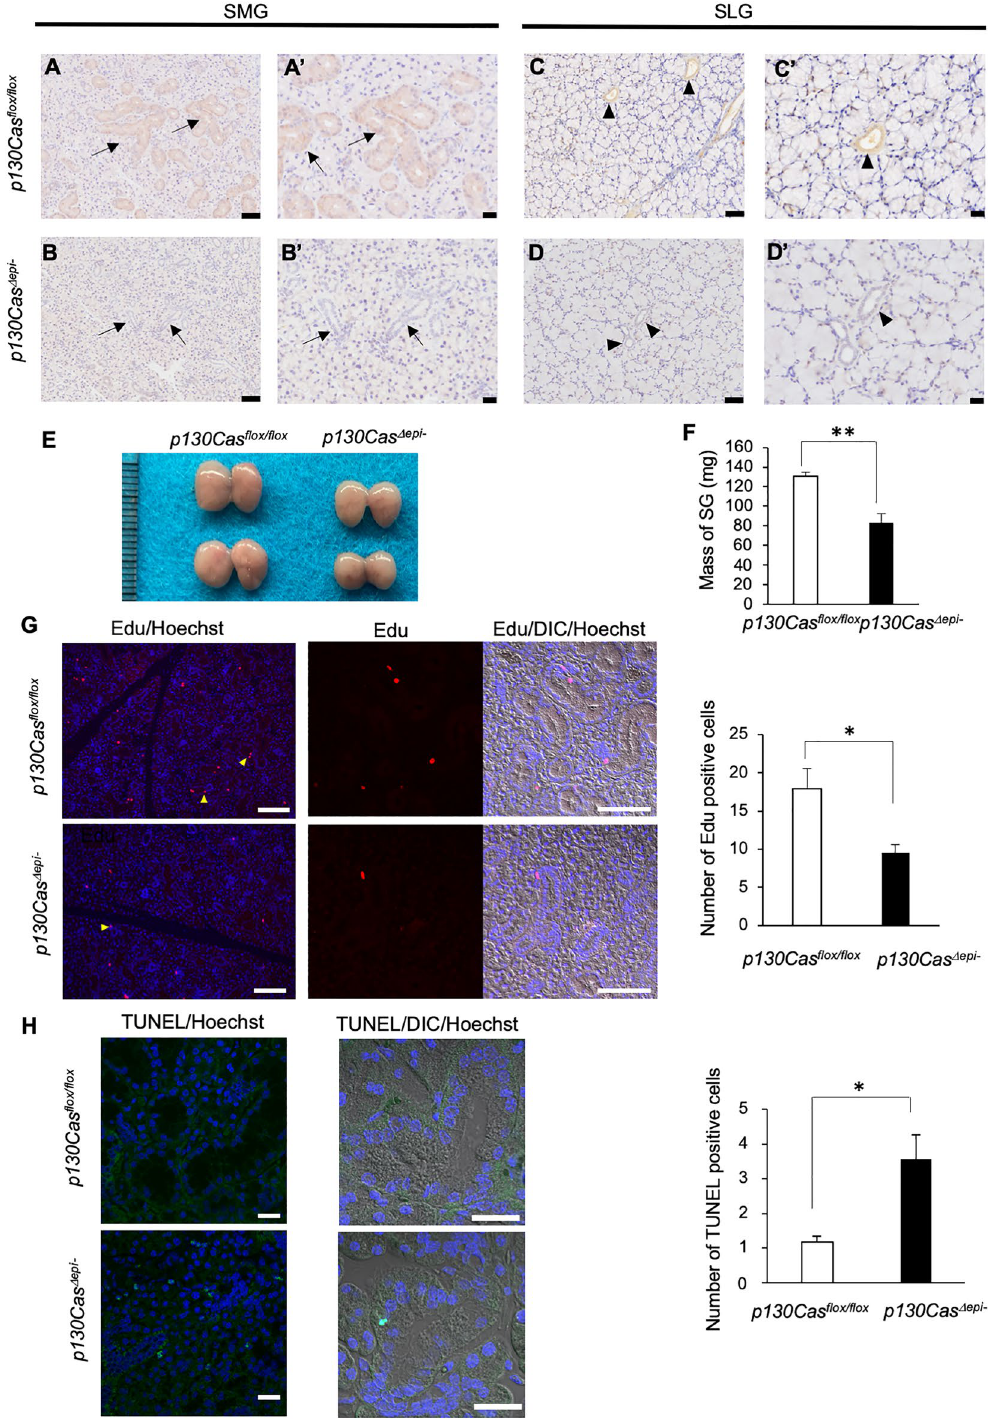
Figure 2. The SMG and SLG phenotypes in p130Cas Δepi– mice. ( A – D ʹ ) Representative images for immunohistochemical staining of SMG ( A – B ʹ ) and SLG ( C – D ʹ ) from P42 p130Cas flox/flox and p130Cas Δepi– mice using an anti-p130Cas antibody. Black boxed regions are shown as magnified images. Scale bars = 50 µm ( A , B , C , D ) and 20 µm ( A ʹ , B ʹ , C ʹ , D ʹ ). Arrows indicate the GCT in SMG. Arrowheads indicate ducts in SLG. ( E ) The gross appearance of the male SMG and SLG in P42 p130Cas flox/flox and p130Cas Δepi– mice. ( F ) The total weight of SMG and SLG (salivary gland; SG) from P42 p130Cas flox/flox and p130Cas Δepi– mice was measured ( p130Cas flox/flox n = 10 mice, p130Cas Δepi– n = 8 mice). ( G ) P42 male p130Cas flox/flox and p130Cas Δepi– mice were injected intraperitoneally with EdU. Six hours later, mice were sacrificed and the SMG were extracted and processed for tissue sectioning. EdU positive cells were detected using the Click-iT Plus Alexa Fluor Picolyl Azide Toolkit and nuclei were counterstained using Hoechst 33,342. Arrowheads indicate EdU-positive cells. EdU signals, Hoechst 33,342 and DIC (Differential interference contrast) merged images are shown. The number of Edu-positive cells per section was quantified. Scale bars = 100 µm. ( H ) Cellular apoptosis was analyzed via the TUNEL assay and nuclei were counterstained with Hoechst 33,342. TUNEL signals, Hoechst 33,342 and DIC merged images are shown. The number of TUNEL-positive cells per field of view was quantified. Scale bars = 25 µm. Data show the means ± SEM, * P < 0.05, ** P < 0.01 versus the corresponding p130Cas flox/flox